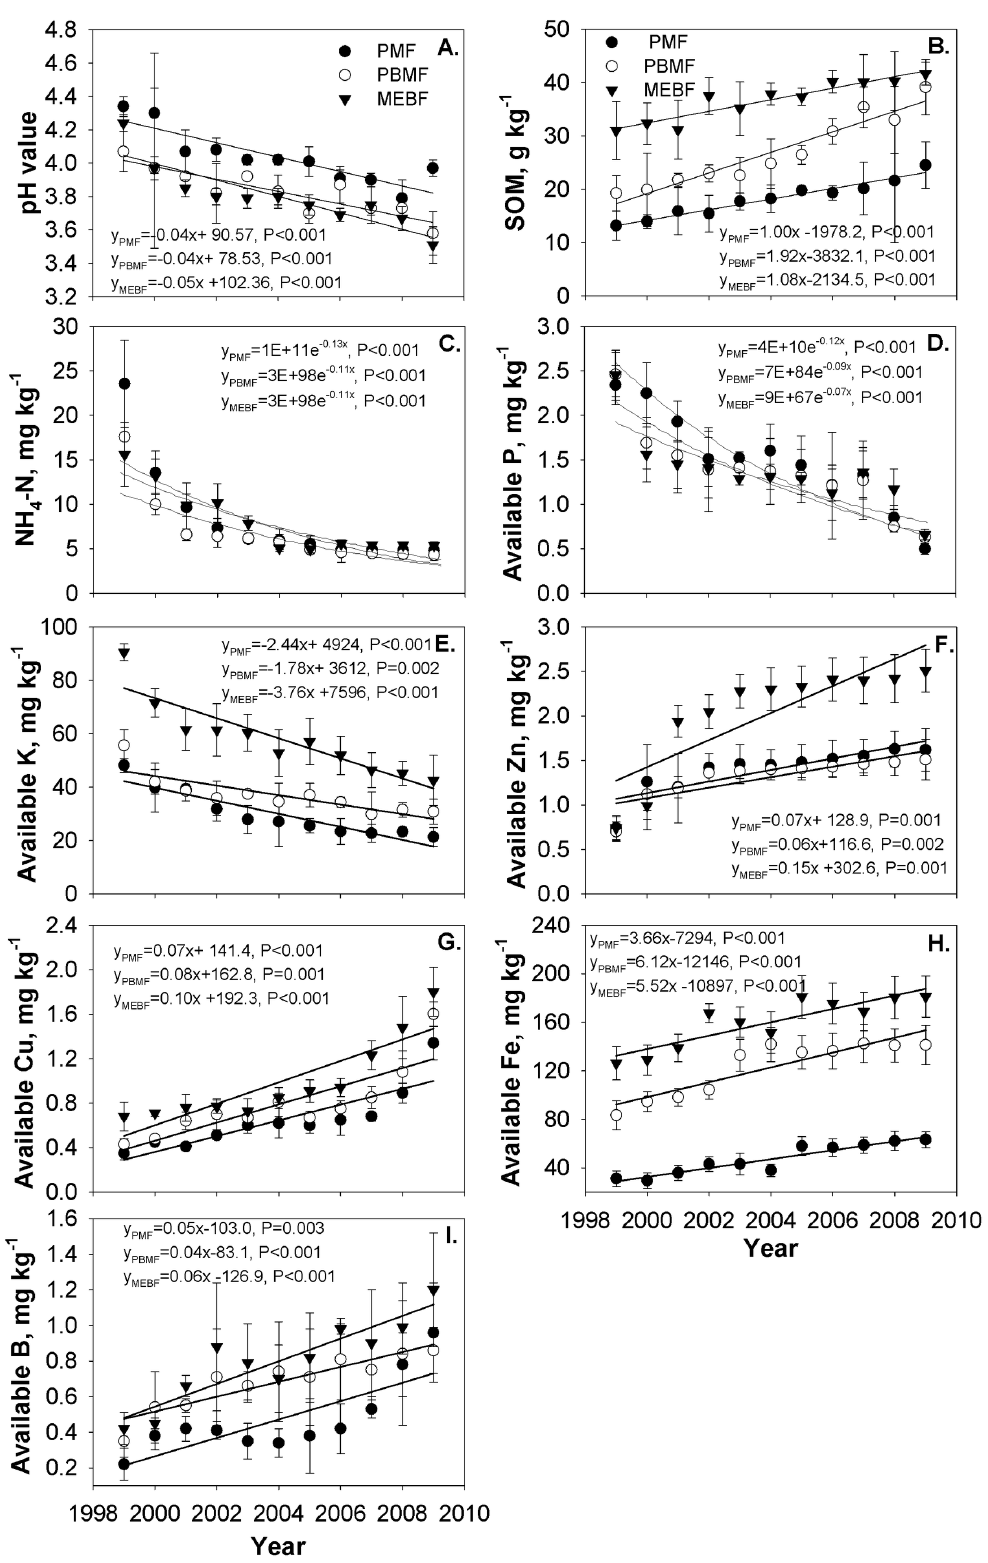
Figure 4. Dynamics of different nutrient contents in the three forest types from 1999 to 2009.